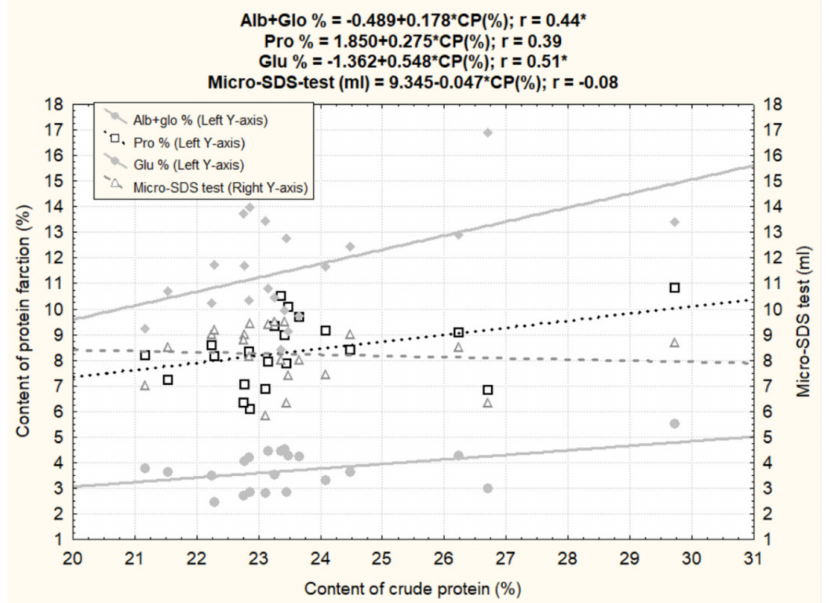
Figure 6. Regression and correlation analyses among crude protein content and content of protein fractions in the tested accessions of Dasypyrum villosum. * correlation values significant at p ≤ 0.05; CP: Crude protein; Alb + Glo: albumins and globulins; Pro: prolamins; Glu: Sum of